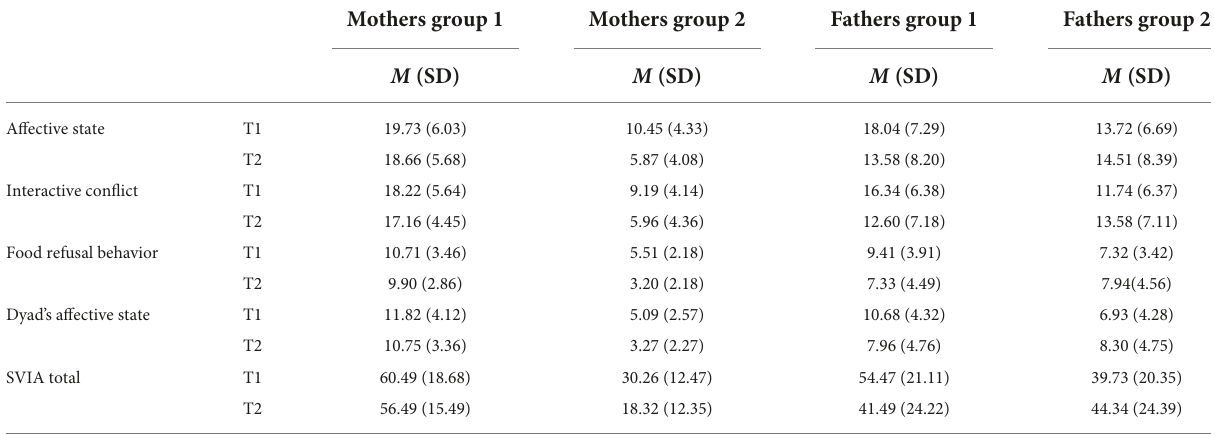
TABLE 3 Average scores and standard deviations of the Scala di Valutazione dell’Interazione Alimentare (SVIA) subscales applied during mother-child and father-child feeding